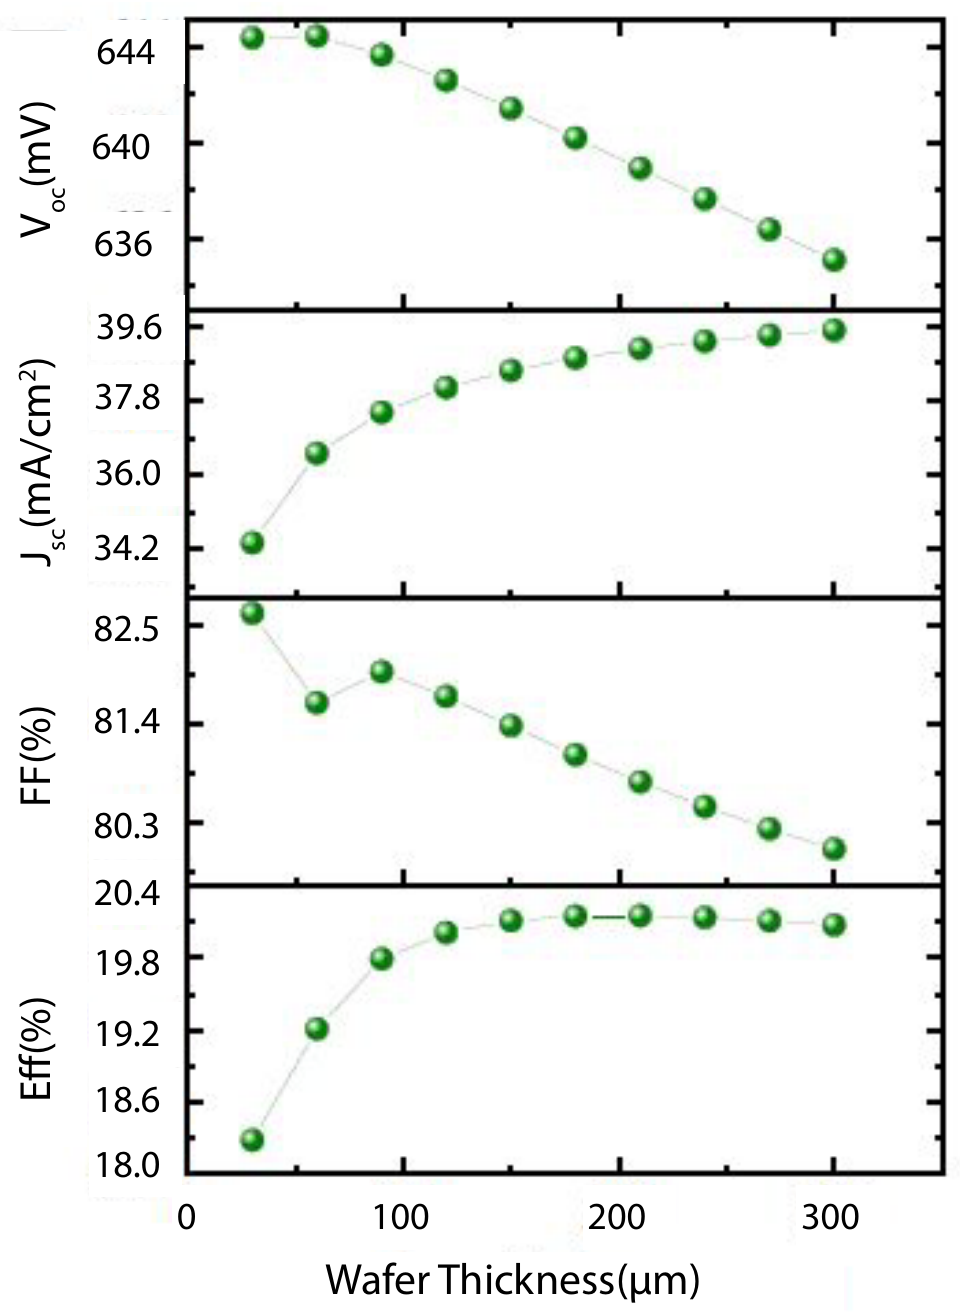
Figure 4. I–V characteristics as a function of wafer